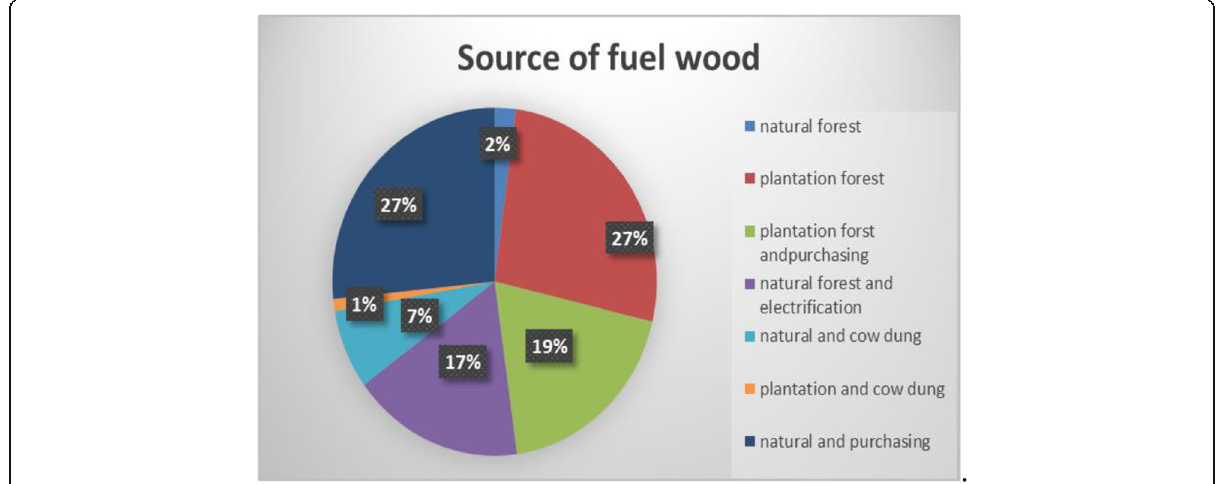
Fig. 2 Sources of fuelwood in Gudo Beret Kebele